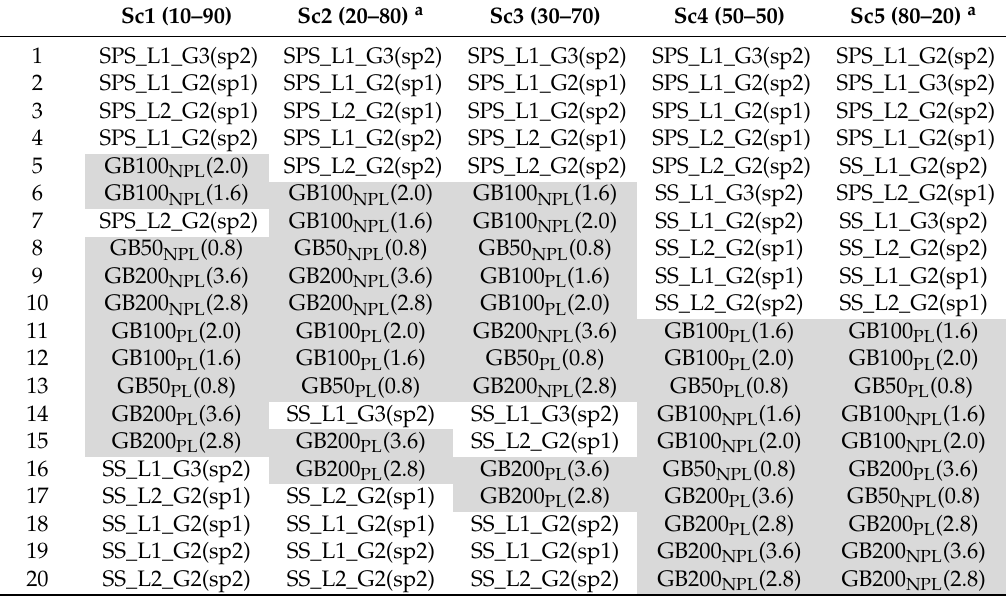
Table 6. Ranking of best alternatives depending on the priorities assigned for various scenarios where weights for water saving change from Sc1 (higher weights for economic results) through Sc5 (higher weights to water savings) when mild-deficit irrigation is adopted for the sprinkler vs. graded border alternatives